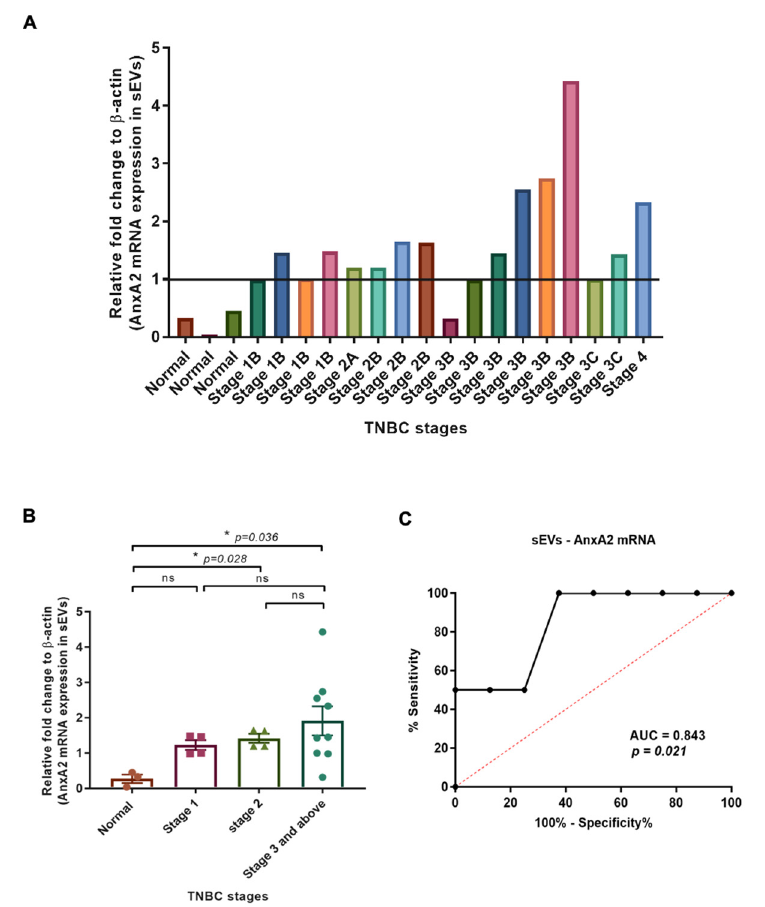
Figure 4. Expression of AnxA2 mRNA in sEVs derived from the TNBC patient serum increases at later stages of cancer and is associated with effective chemotherapy response. ( A ) Analysis of AnxA2 mRNA levels by qRT-PCR in normal and TNBC patient serum-derived sEVs as given in Table 3 from 1–20. The graph shows quantification (fold change) after calculating the 2 − ∆∆ Ct values. The Ct values were taken as the average of two readings for the calculation of 2 − ∆∆ Ct (normal samples—1,2,3; the patient numbers with stage 1-no chemotherapy-4,5,6,7; stage 2-no chemotherapy-8,10, and 11; stage 2 with chemotherapy—9; stage 3 and above-no chemotherapy-14; stage 3 and above with chemotherapy-12,13,15,16,17,18,19,20). ( B ) The graphical representation shows the comparison of the means of the mRNA expression (n-fold change) in sEVs derived from the TNBC patient sample from each stage. (mean ± SEM, n = 3 for normal samples, n = 4 for stage 1, n = 4 for stage 2, and n = 9 for stage 3 and above; * p < 0.05). ( C ) ROC curve for serum sEV-AnxA2 mRNA as a biomarker alone for the prediction of responsiveness or non-responsiveness to neoadjuvant chemotherapy in the TNBC patients with stage 3 and above (n =